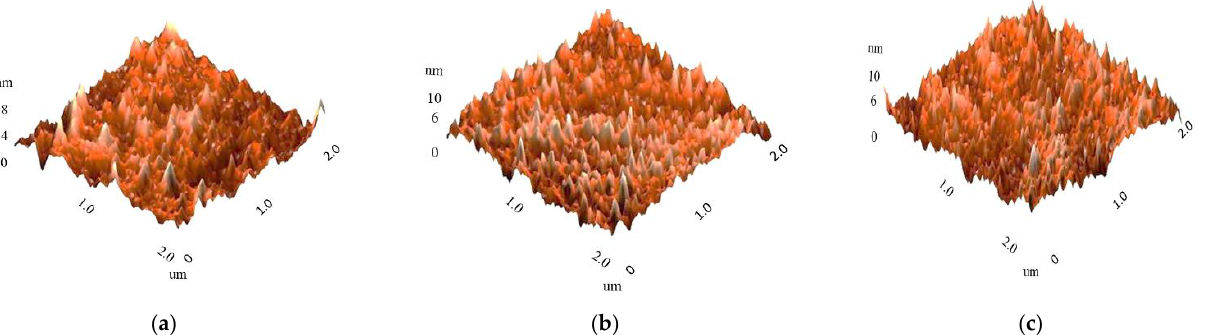
Figure 4. AFM images of InTiZnO thin film of ( a ) Sample B (RMS value: 1.1 nm), ( b ) Sample C (RMS value: 1.2 nm), ( c ) Sample D (RMS value: 1.4 nm).